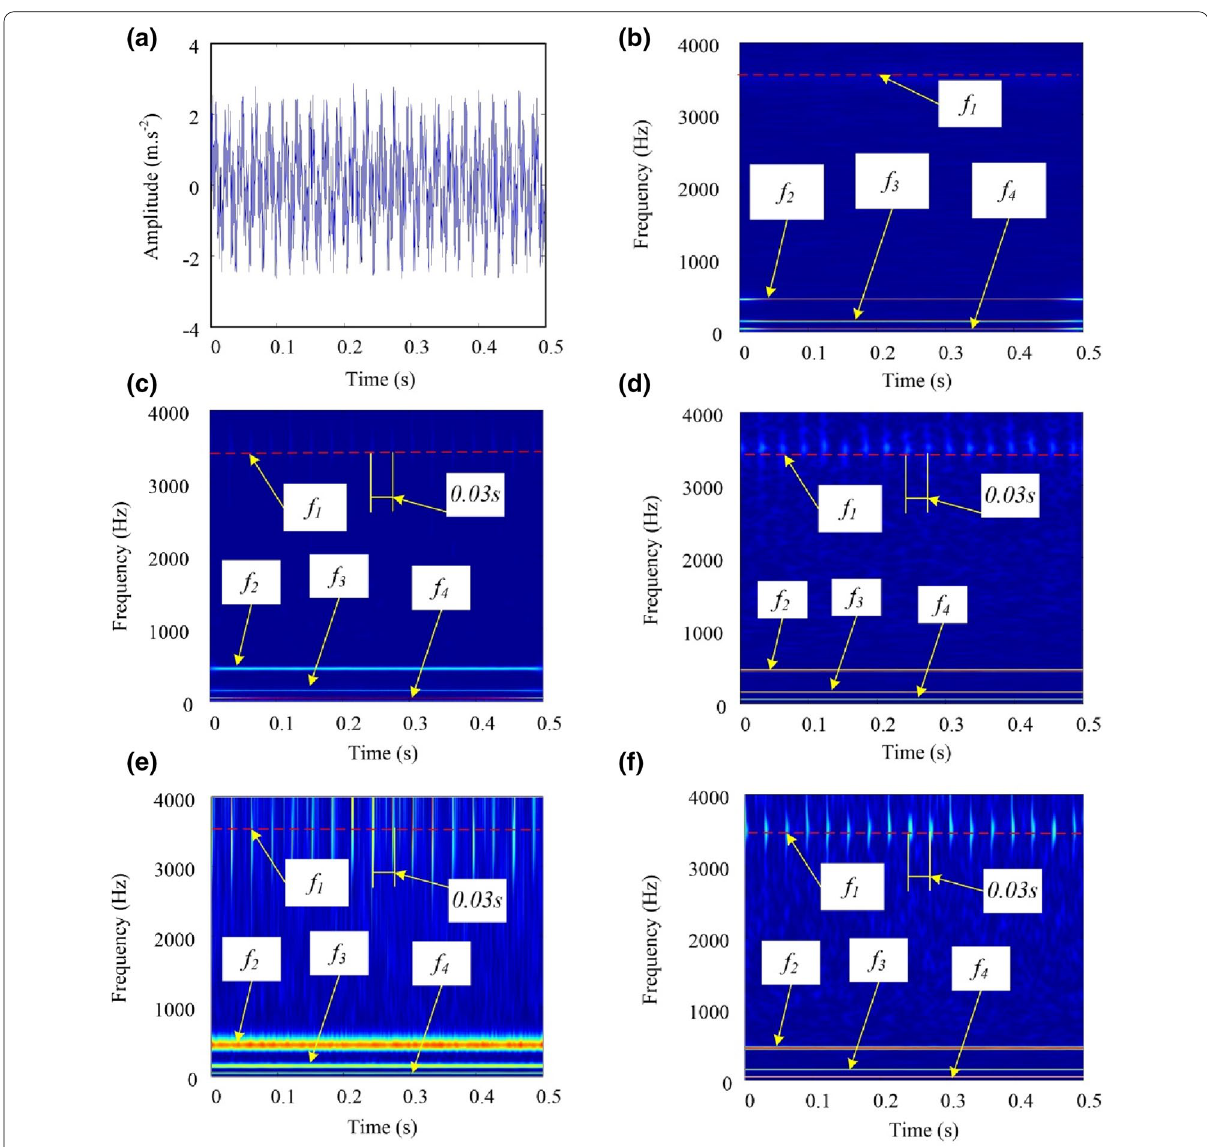
Figure 3 Waveform of simulated signal and its time-frequency spectra: ( a ) time domain waveform, ( b ) STFT, ( c ) CWT, ( d ) GST with p with p 1, (f) GST with p opt = =